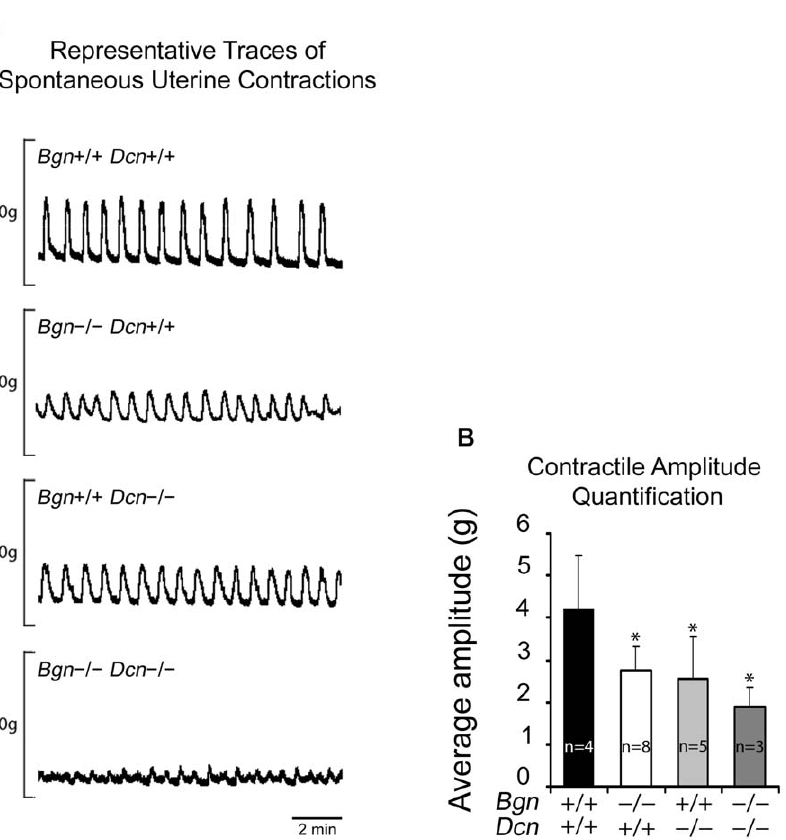
Figure 3. Abnormal uterine contractions in biglycan/decorin knockout mice. A: Representative contractile force tracings of spontaneous isometric uterine contractions display phenotypic differences per genotype. The wild-type displays regular, phasic contractions. In contrast, the absence of biglycan, decorin, or both, leads to decreased amplitude. B: Quantification of isometric uterine contractile amplitudes. The waveform amplitude is decreased in all knockouts compared to the wild-type. P =0.012. One way ANOVA Holm-Sidak. Error bars=SD. Bgn =biglycan. Dcn =decorin.